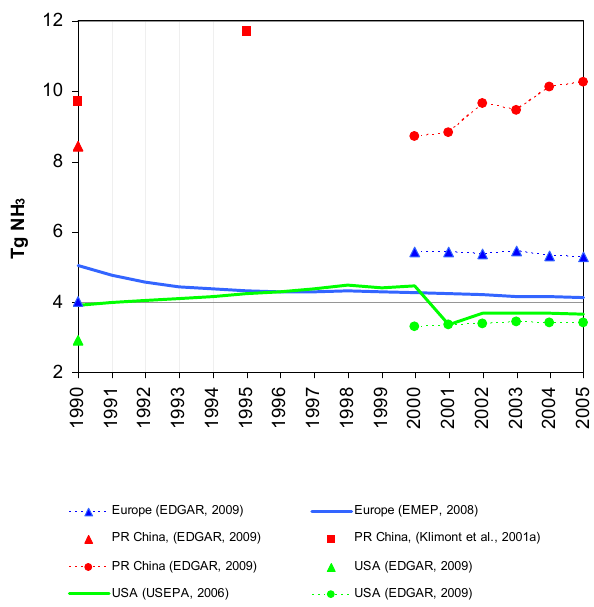
Fig. 8. Estimated trends in NH 3 emissions in Europe, the US and the People’s Republic of China for the period 1990-2005 Apart from the analysis of emission inventories for specific years, which give a snapshot for a certain point in time, looking at the temporal trends in emissions can give valuable insight in the development of both emissions as well as the methodologies applied for their calculation. The trend for NH 3 emissions (Fig. 8) shows no significant reductions in the 15 year period indicated. A moderate downward trend can be observed in Europe (-18%), which is largely attributable to the political restructuring of Eastern Europe after 1989 (Horvath and Sutton, 1998) while US emissions have increased slightly in the period from 1990 to 2000. Although the values shown in Figure 8 indicate a small (6%) reduction below 1990 for 2005, this is due to a change in the calculation methodology in 2000, which was has not been reapplied to the earlier years.